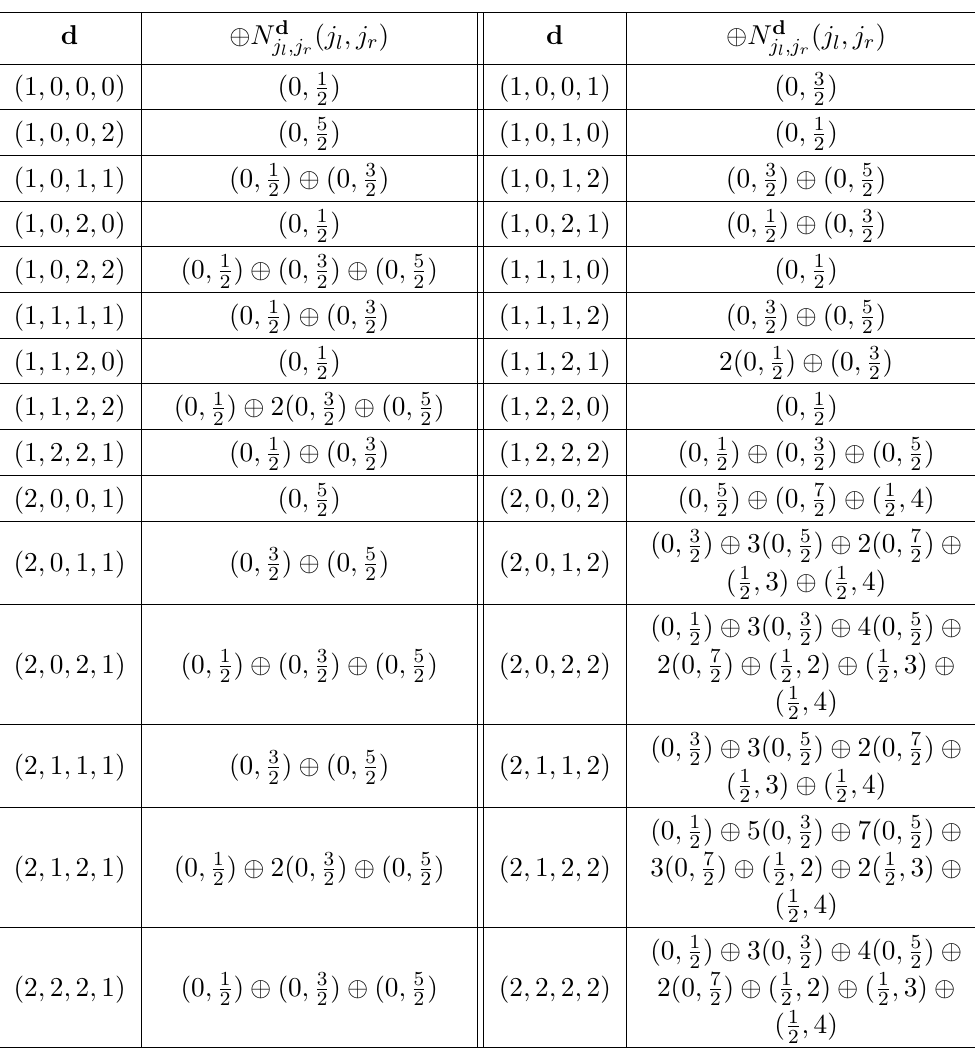
Table 11 . BPS spectrum of SU(4) 6 theory for d i ≤ 2 . Here, d = ( d 1 , d 2 , d 3 , d 4 ) labels the BPS states with fugacity Q Q d i i